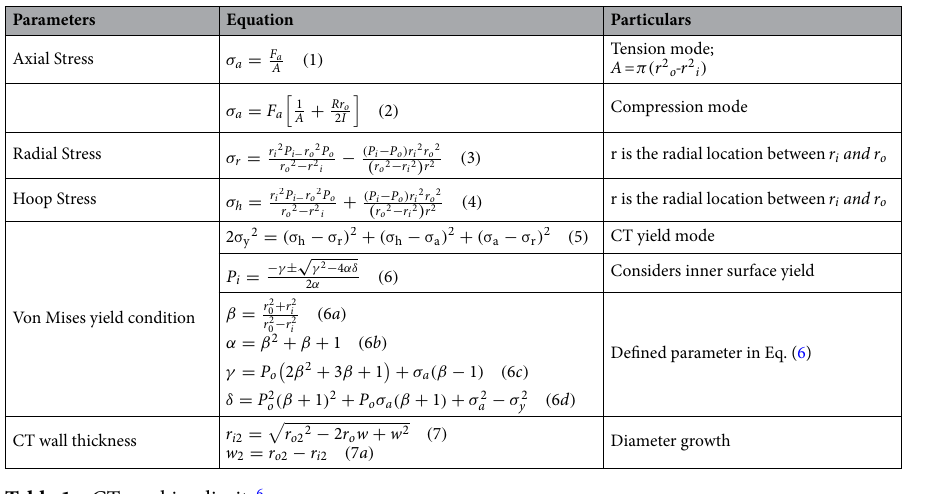
Table 1. CT working limits 6